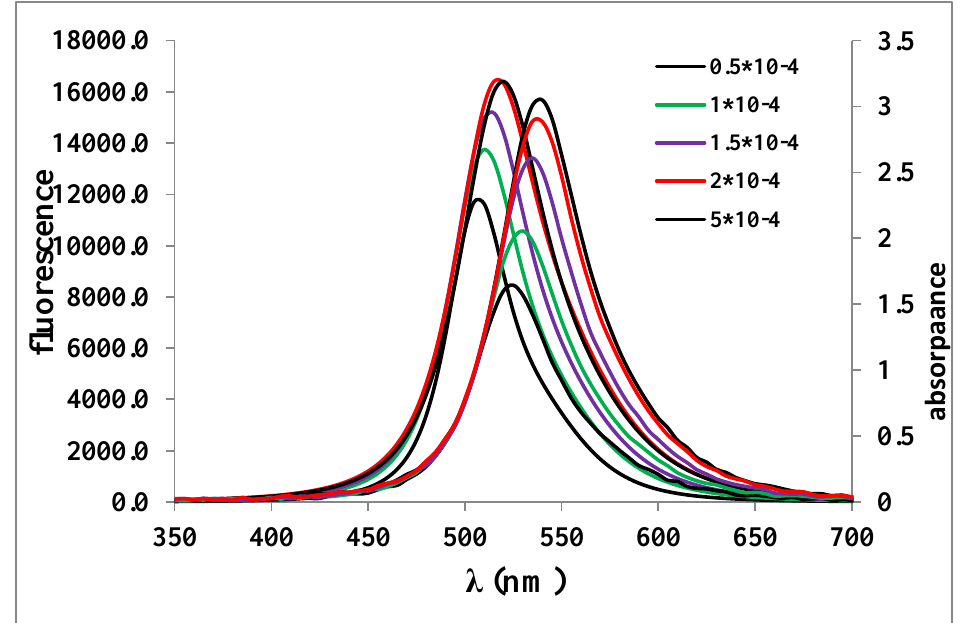
Fig. 6: The overlap between fluorescence spectra of coumarin 334 dye and absorption spectra of Rhodamine 590 dye solution at different molar